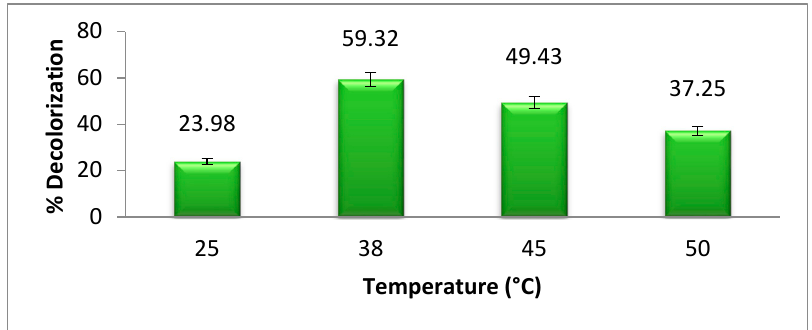
Figure 5. Effect of temperature on methyl orange degradation.